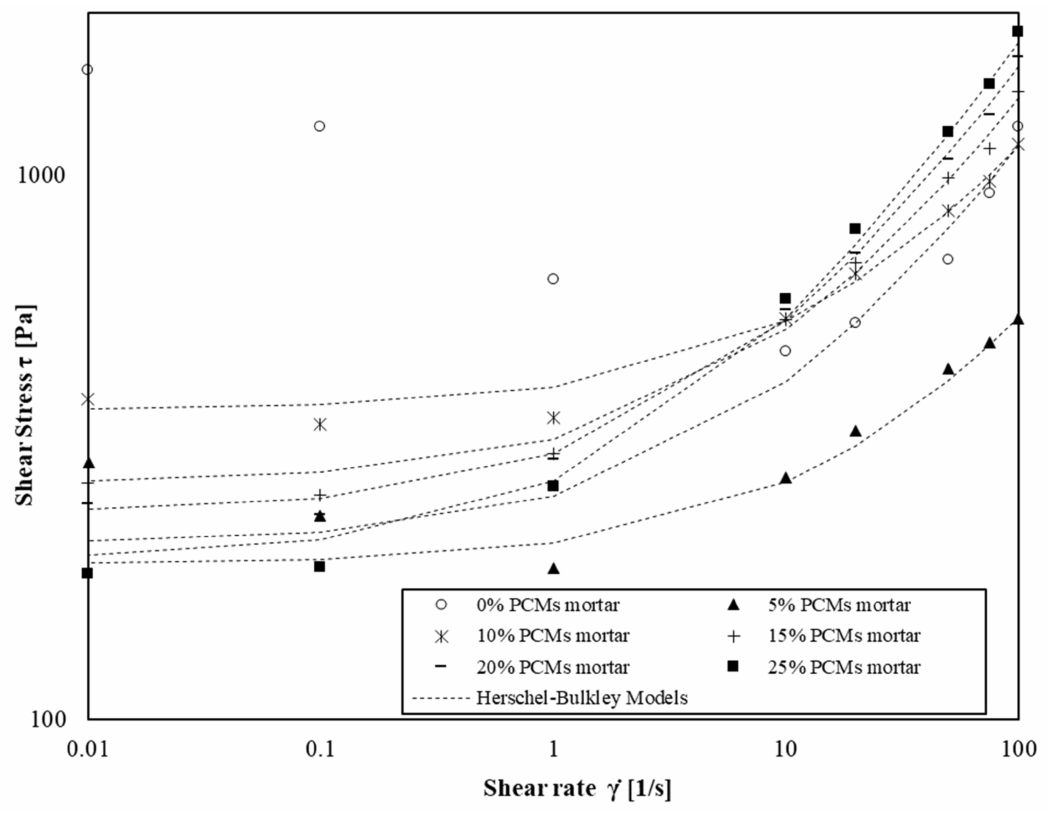
Figure 10. Shear flow curves of mortars with amount of s/s PCMs ranging 0 wt% to 75